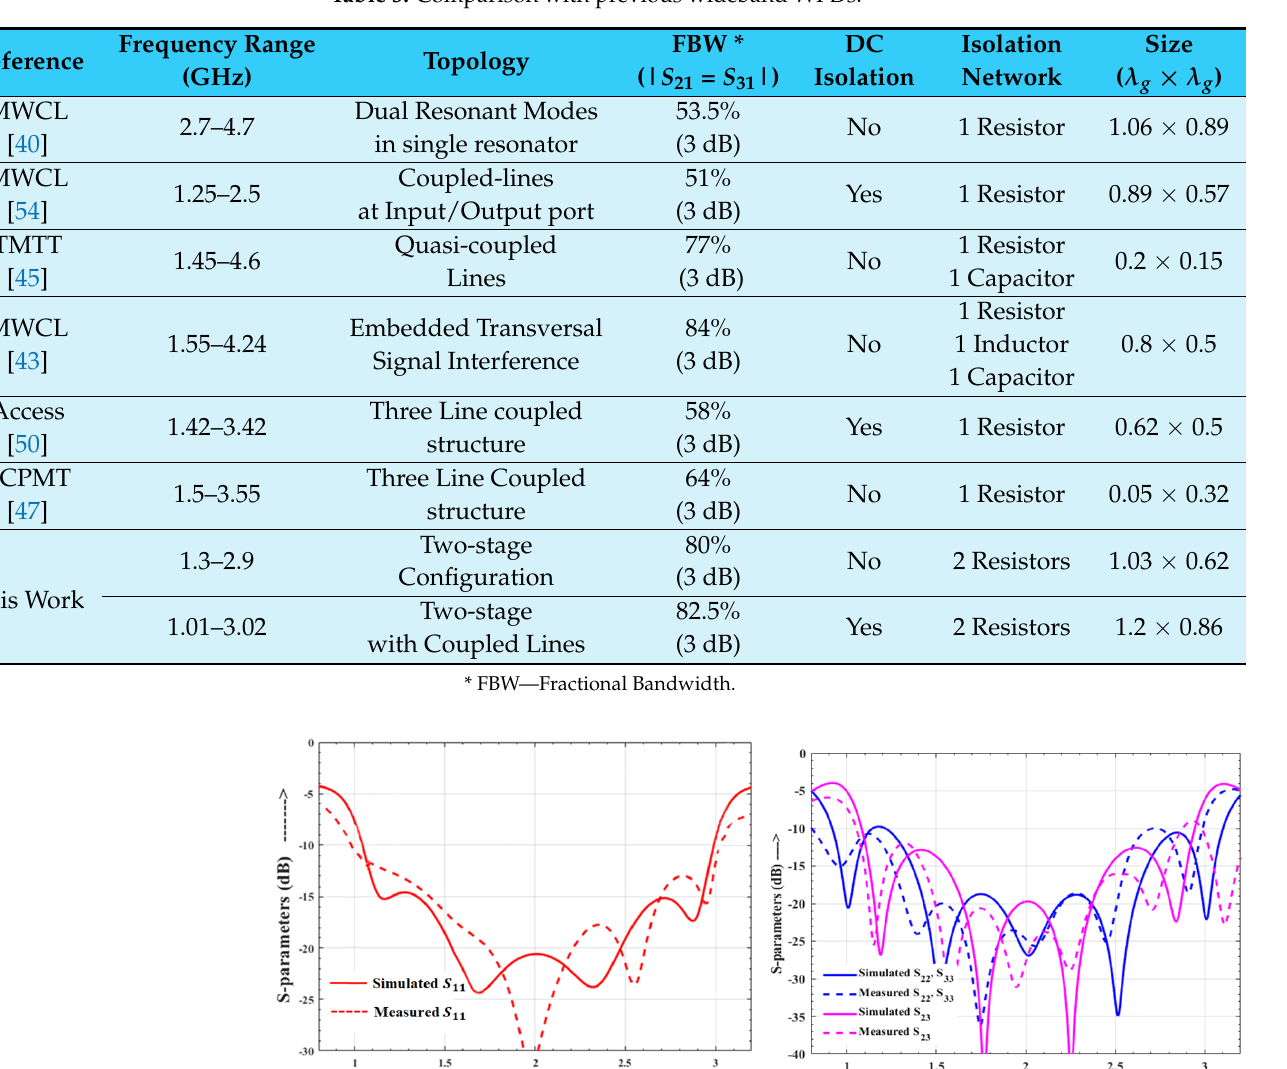
Figure 24. EM vs. Measured S-parameters for ( A ) S 21 ; ( B ) S 31 for θ c = 55 ◦ . Table 3. Comparison with previous wideband WPDs.